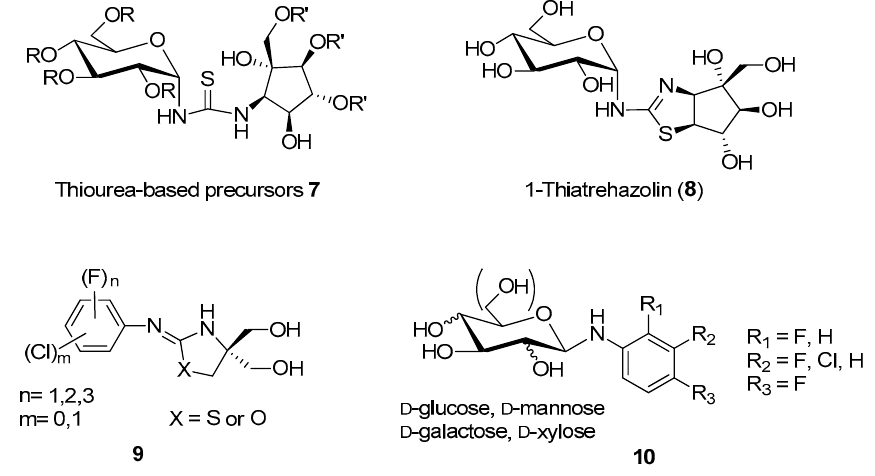
Figure 2. Structures of synthetic carbohydrate-, carbocyclic-, and heterocyclic-based trehalase inhibitors.